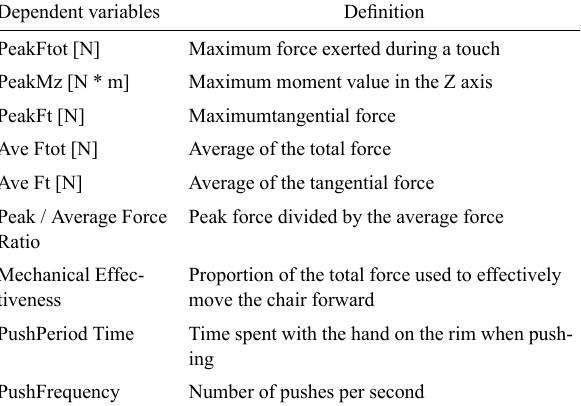
Table 1 - Kinetic variables measured with the SmartWheel system.